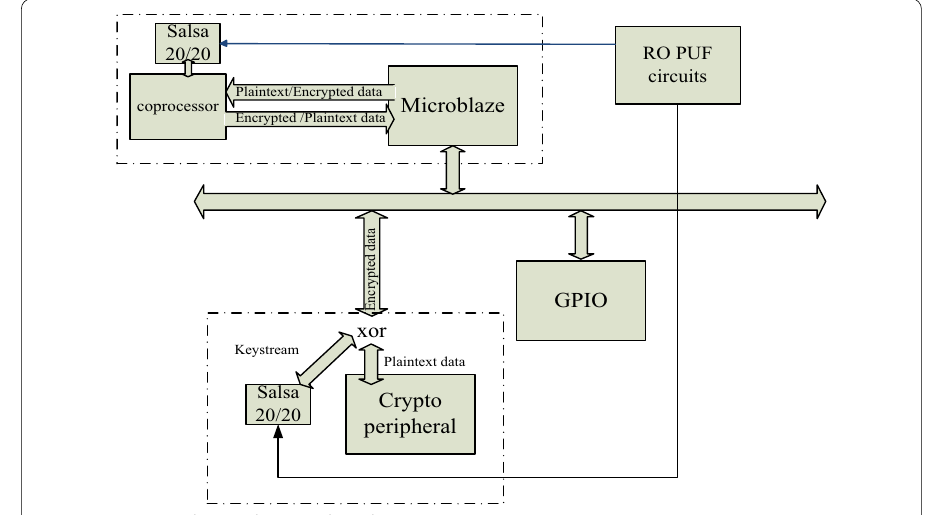
Fig. 5 System on Chip implemented in Xilinx EDK